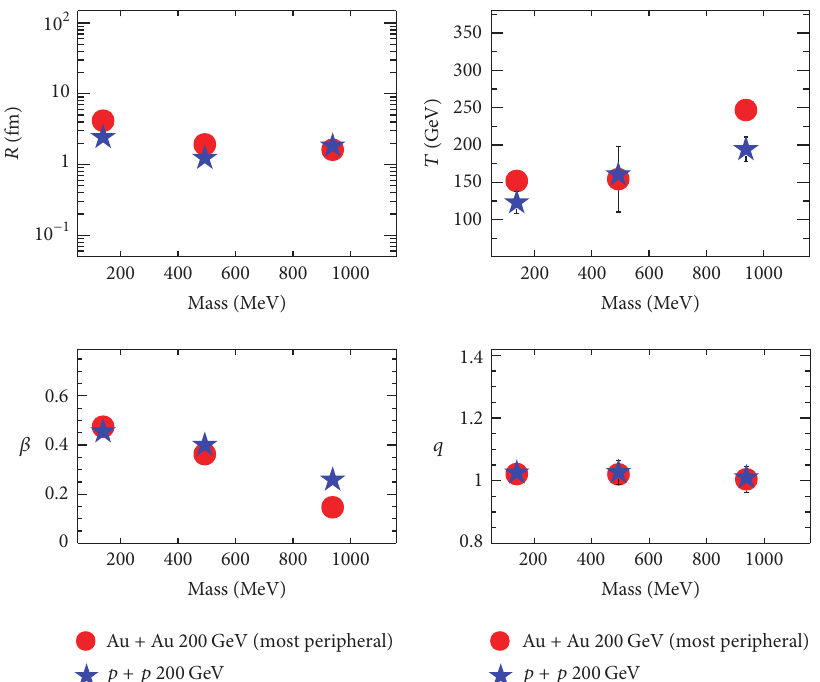
Figure 9: Mass dependence of extracted thermodynamic parameters of Tsallis distribution including radial flow using (8) for most peripheral Au + Au collisions and 𝑝 + 𝑝 collisions at √𝑠 NN = 200 GeV.